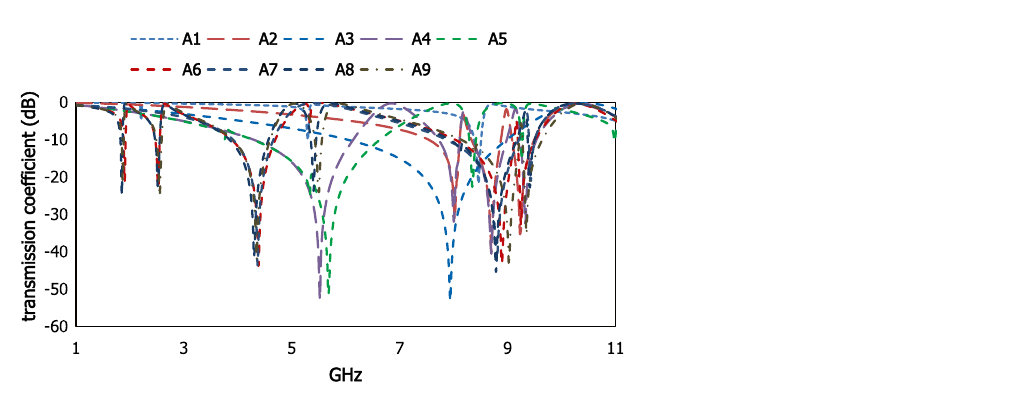
Figure 6. Results for different